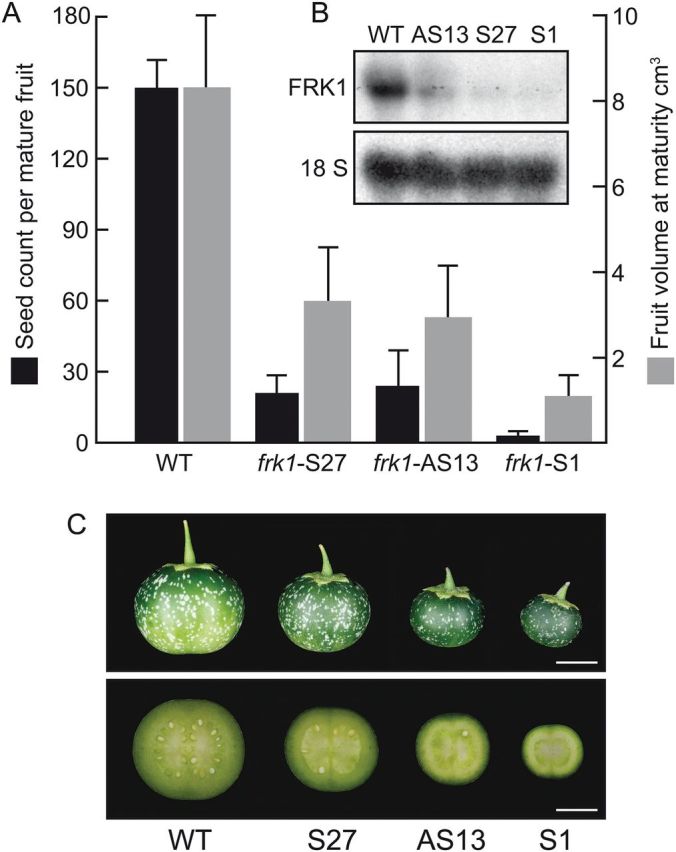
Analyses of ScFRK1 transgenic plants. (A) Seed count and fruit volume measurements from WT plants and transgenic lines S1, S27, and AS13. (B) RNA gel blot analyses of ScFRK1 mRNA (upper panel) and 18S rRNA (lower panel) of ovary tissues derived from WT plants and transgenic lines S1, S27, and AS13. (C) Comparison of fruits and fruit slices from WT plants and transgenic lines S1, S27, and AS13. Scale bar=1cm. (This figure is available in colour at JXB online.)